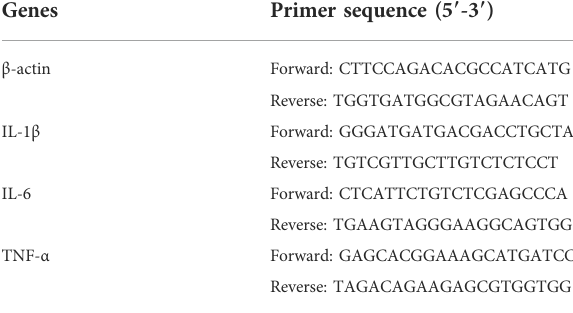
TABLE 1 Primer sequences of target genes for